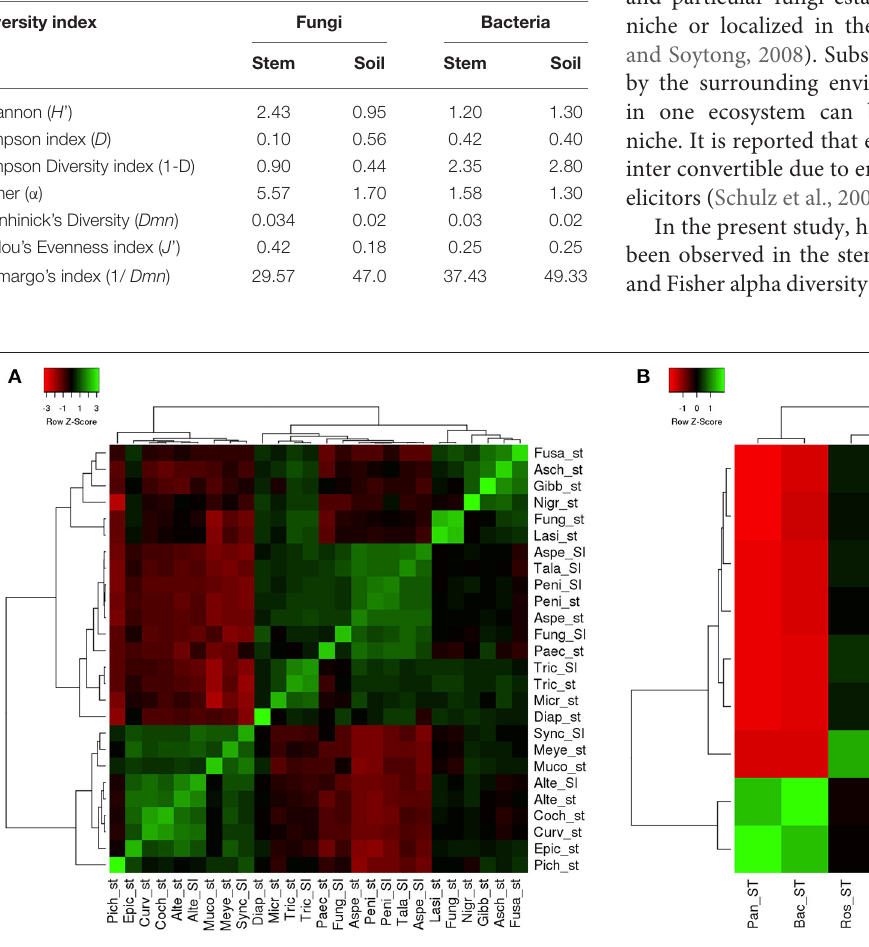
FIGURE 5 | Heat map analysis of (A) fungi and (B) bacterial isolates from stem and soil samples. St, stem isolate; Sl, Soil isolate; Pich, Pichia ; Epic, Epicoccum ; Curv, Curvularia ; Coch, Cochliobolus ; Alte, Alternaria ; Muco, Mucor ; Meye, Meyerozyma ; Sync, Syncephalastrum ; Diap, Diaporthe ; Micr, Microdiplodia ; Tric, Trichoderma ; Pace, Paecilomyces ; Fung, Fungal; Aspe, Aspergillus ; Peni, Penicillium ; Tala, Talaromyces ; Lasi, Lasiodiplodia ; Nigr, Nigrospora ; Gibb, Gibberella ; Asch, Aschersonia ; Fusa, Fusarium ; Pan, Pantoea ; Bac, Bacillus ; Ros, Roseomonas; Lys, Lysinibacillus ; Pae, Paenibacillus ; Ste, Stenotrophomonas ; Pse, Pseudomonas.